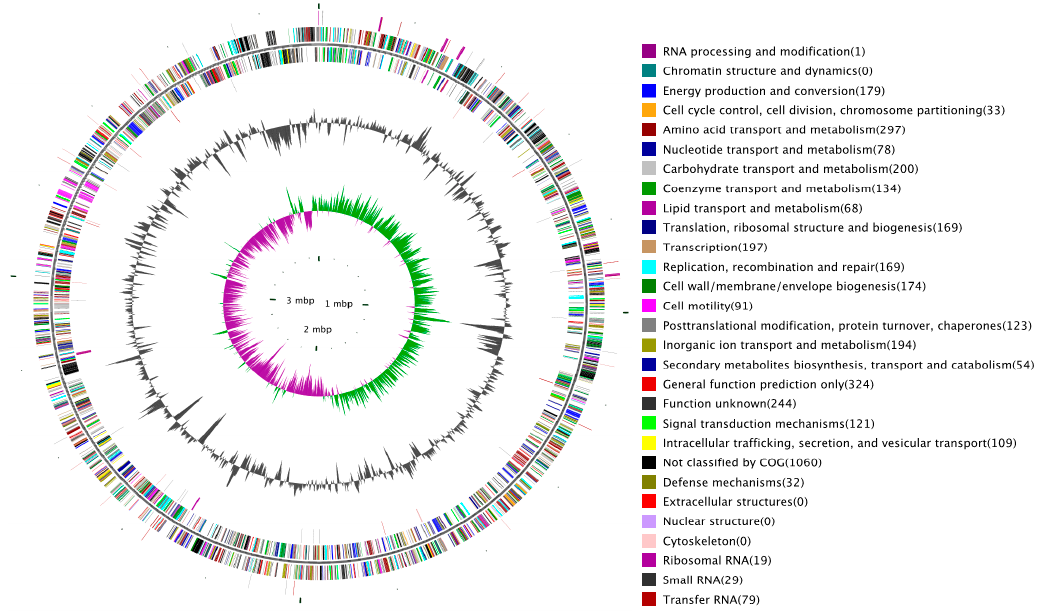
Figure 2. Genome map of Yersinia ruckeri SC09. Starting from the outermost ring and moving inwards, the rings show the location of (1) noncoding RNA on the leading strand; (2) all annotated CDS on the leading strand (colors indicating the assigned COG classes); (3) all annotated CDS on the lagging strand (colors indicating the assigned COG classes); (4) noncoding RNA on the leading strand; (5) The two innermost rings show the GC content (black), GC skew+ (green), and GC skew-(dark purple). The legend at the right explains the colors used to indicate the functional COG groups (Figure S4). Table 2. Information of interspersed repetitive sequences.